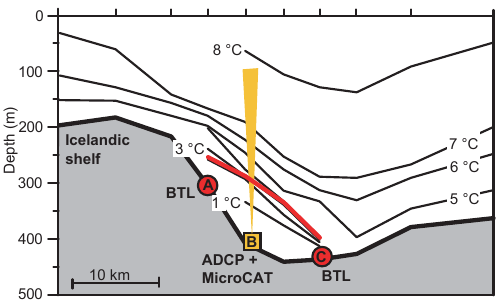
Figure 5. Section through the three moorings of the field exper- iment (Fig. 4, thick black line). The yellow square marks the lo- cation of the ADCP at site B with the yellow cone indicating the maximal ADCP range. Red circles at sites A and C mark bottom temperature loggers (BTLs). The isotherms show the temperature distribution on 20 May 2017 based on 10 CTD stations (marked on top) observed by R/V Magnus Heinason . The red line shows the σ θ = 27 . 8kgm − 3